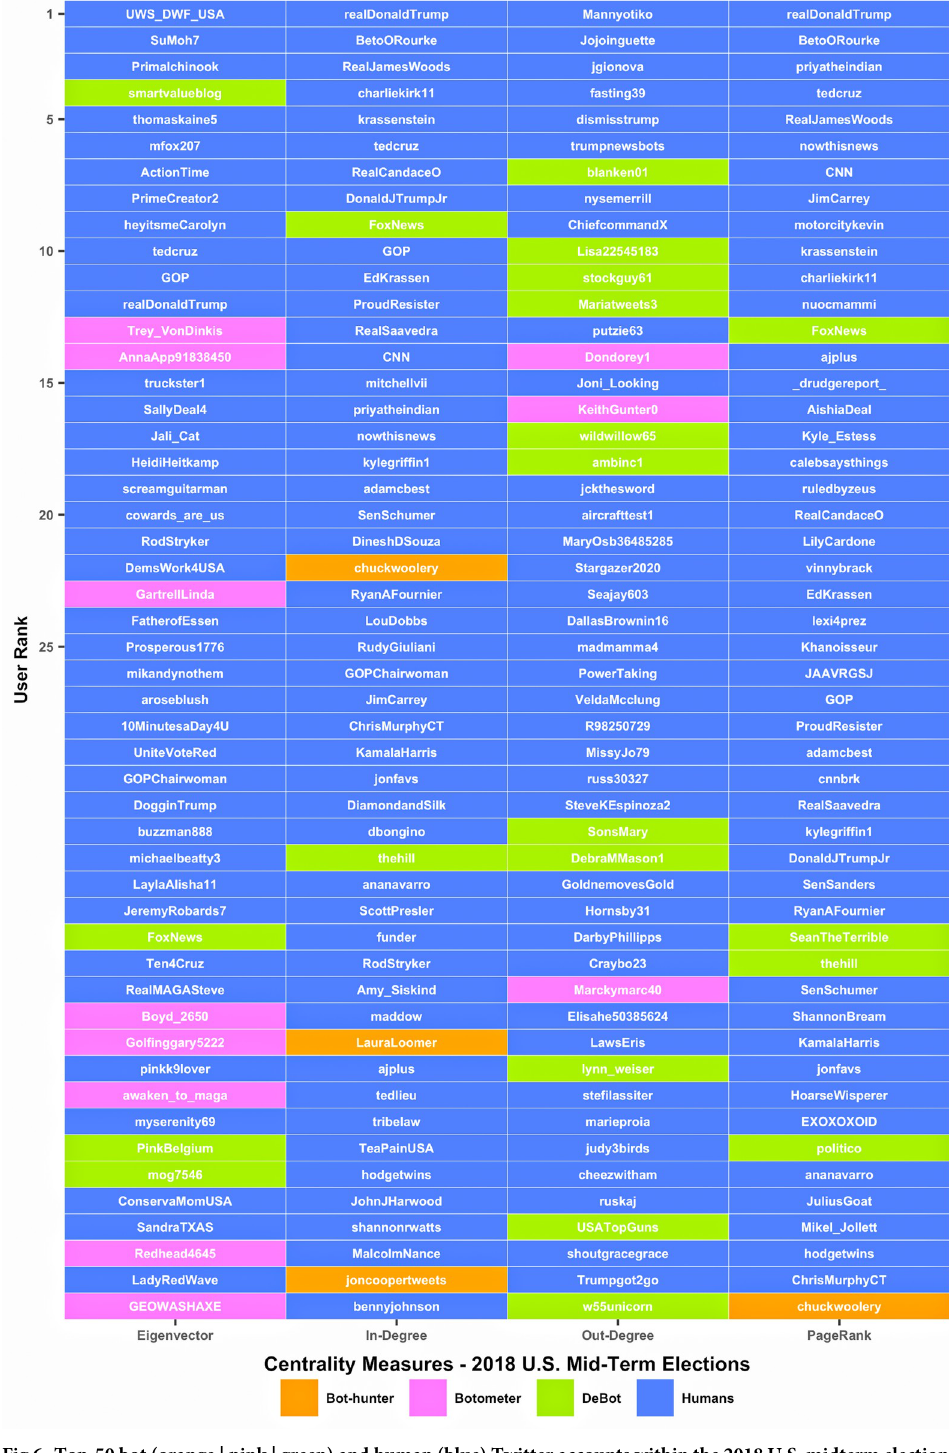
Fig 6. Top-50 bot (orange | pink | green) and human (blue) Twitter accounts within the 2018 U.S. midterm election retweet network ranked by the following four centrality measures: (1) eigenvector, (2) in-degree, (3) out-degree and (4)